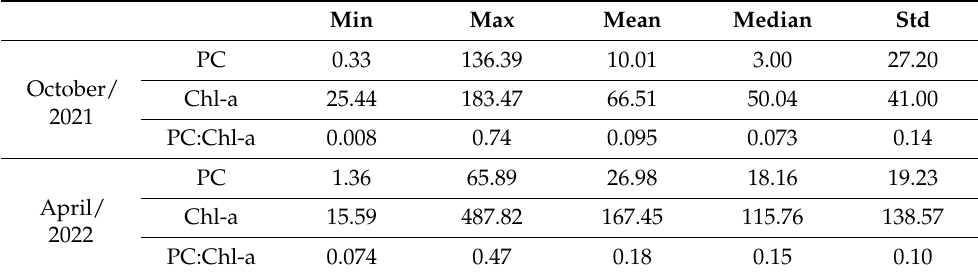
Table 1. Descriptive statistics from phycocyanin (mg.m − 3 ) and chlorophyll-a (mg.m − 3